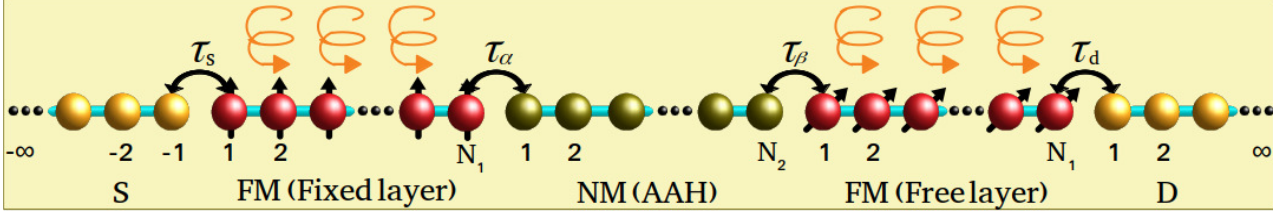
Figure 1. (Color Online). Schematic diagram of the magnetoresistance setup in a trilayer structure, which is connected to a non-magnetic source (S) and drain (D) electrodes through the couplings τ S and τ D , respectively. The bridging conductor is made up of a non-magnetic spacer ( N 2 sites), subjected to AAH potential, and two ferromagnetic layers ( N 1 sites in each layer) that are irradiated with